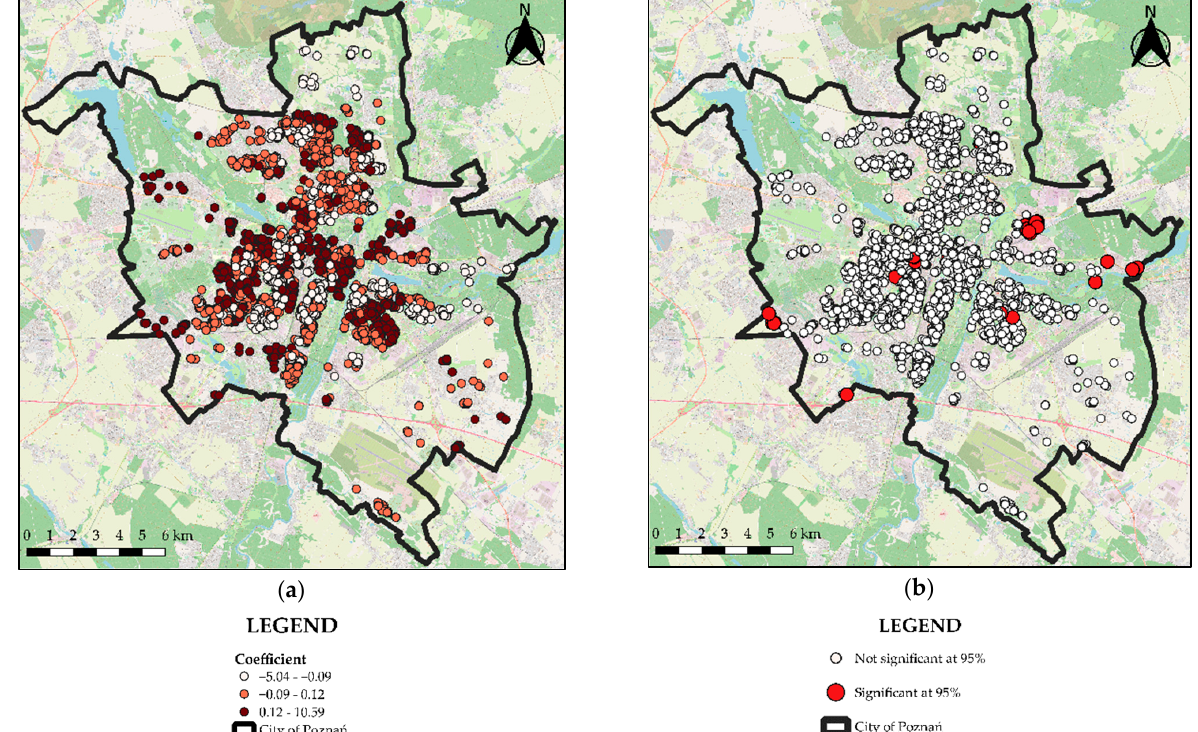
Figure 6. ( a ) Local estimated coefficients—DB. ( b ) Statistical significance of estimated coefficients—DB.